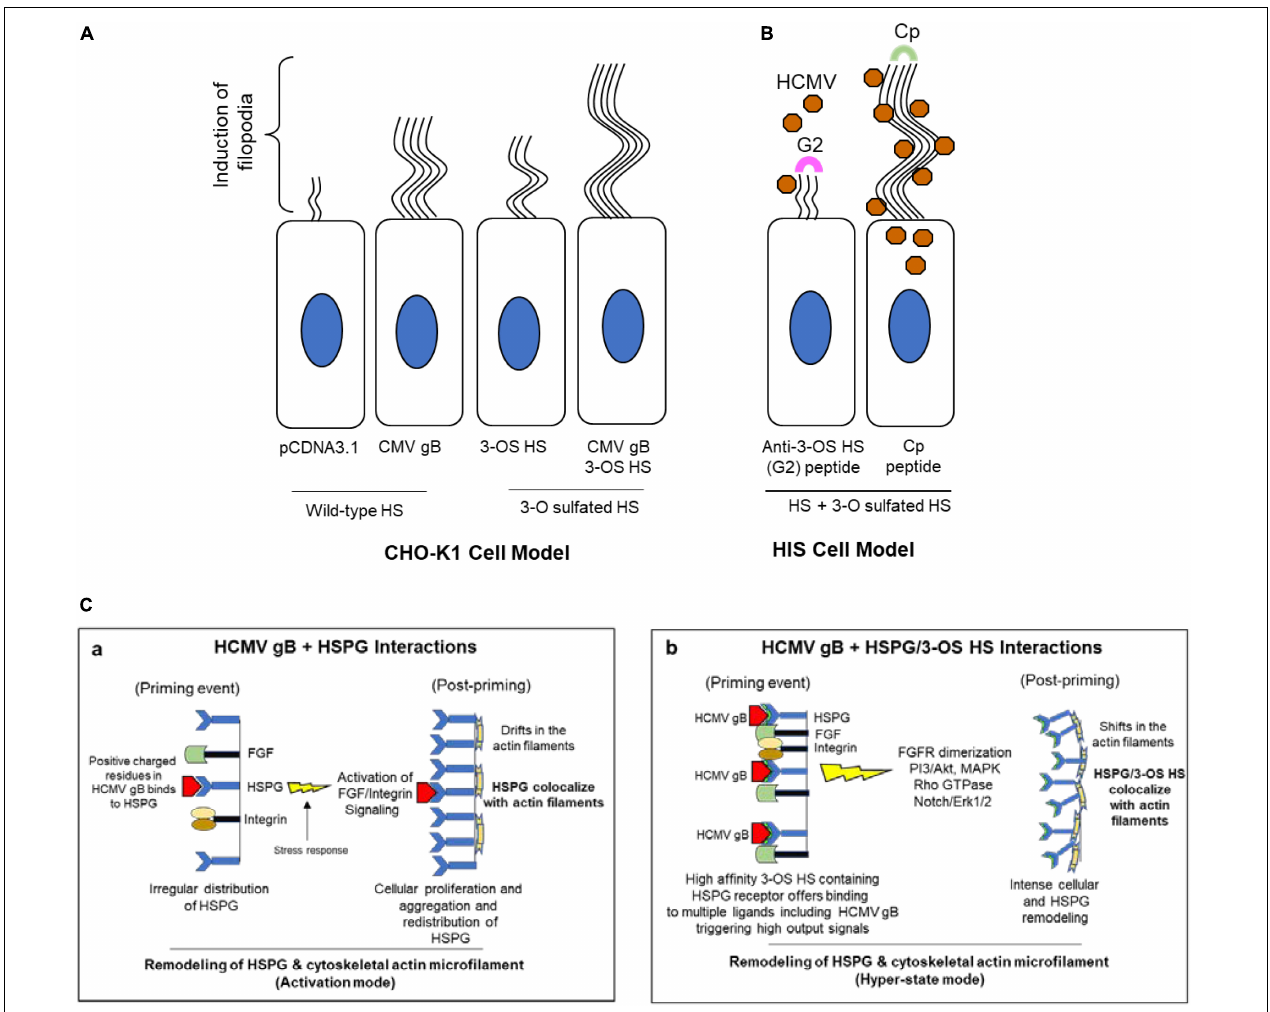
FIGURE 5 | Induction of filopodial system under different conditions in HCMV entry models. (A) In CHO-K1 cell model, a higher number of filopodial extensions were noticed during co-expression of HCMV gB together with 3- O ST-3 enzyme. (B) In primary cultures of HIS cell model, the blocking of 3-O sulfation in HS chain by the pre-treatment of the cells with anti-3- O S HS (G2) peptide but not the control peptide (Cp) negatively impacts the filopodia including the virus infectivity. (C) Significance of ligand–receptor interactions as an important determinant for crosslinking the HSPG receptor along with the actin cytoskeleton for a remodeling event during HCMV entry. Essentially, HCMV gB interactions with wild-type HSPG likely leads to a productive actin and HSPG remodeling (a), while in the presence of a high-affinity 3- O S HS ligand, a hyper state remodeling event goes in effect (b) due to the multi-ligand–receptor interactions resulting from an intense cellular change including a high turnover in